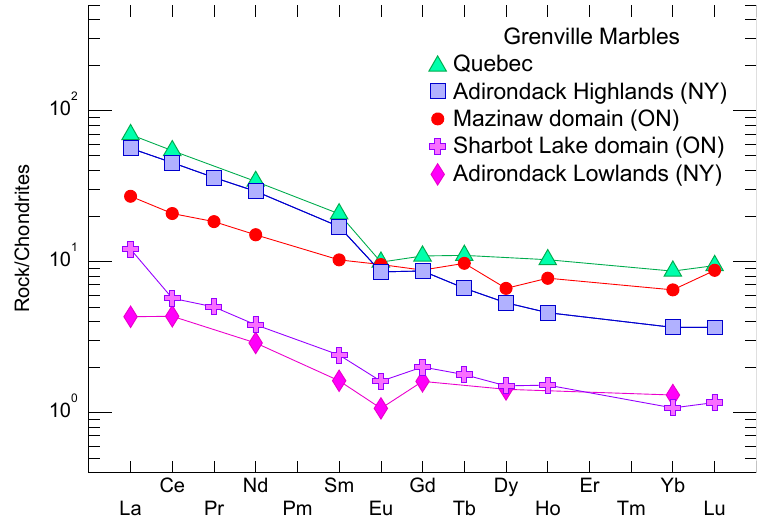
Figure 9. Average Rare Earth Element composition of Grenville marbles, normalized to chondrite [26]. See text for sources of data.